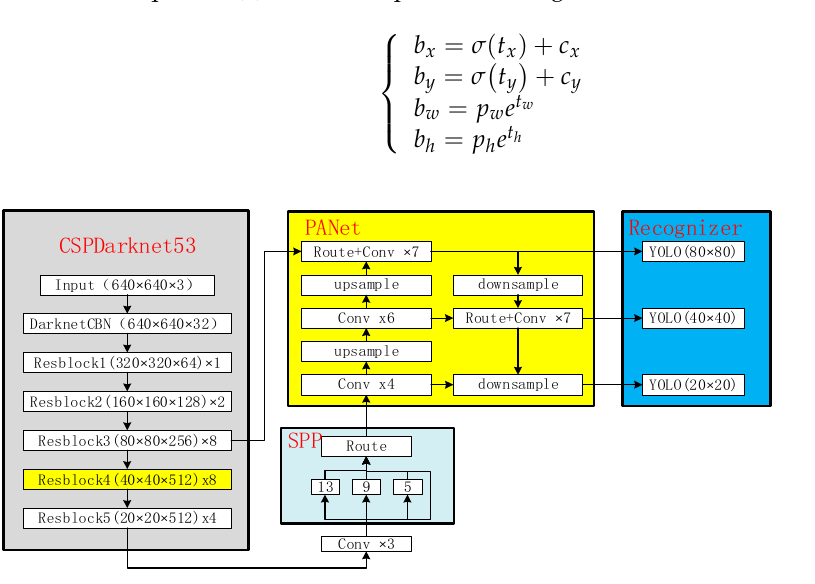
Figure 1. The network structure of YOLOv4.